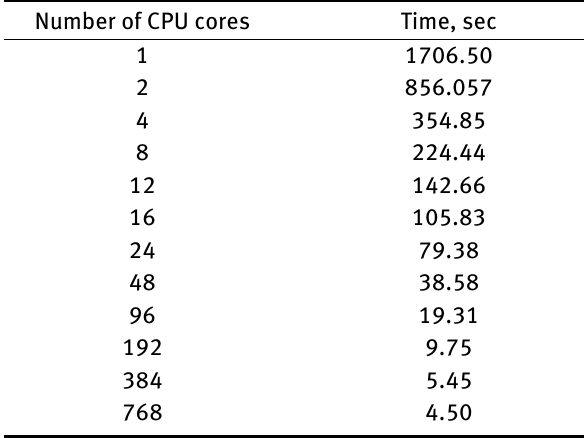
Table 5: Parallel advection-coagulation solver on CPUs, Ballistic kernel, domain size N × M = 12288 , 16 time-integration steps. This benchmark utilized up to 32 nodes from the CPU segment of the